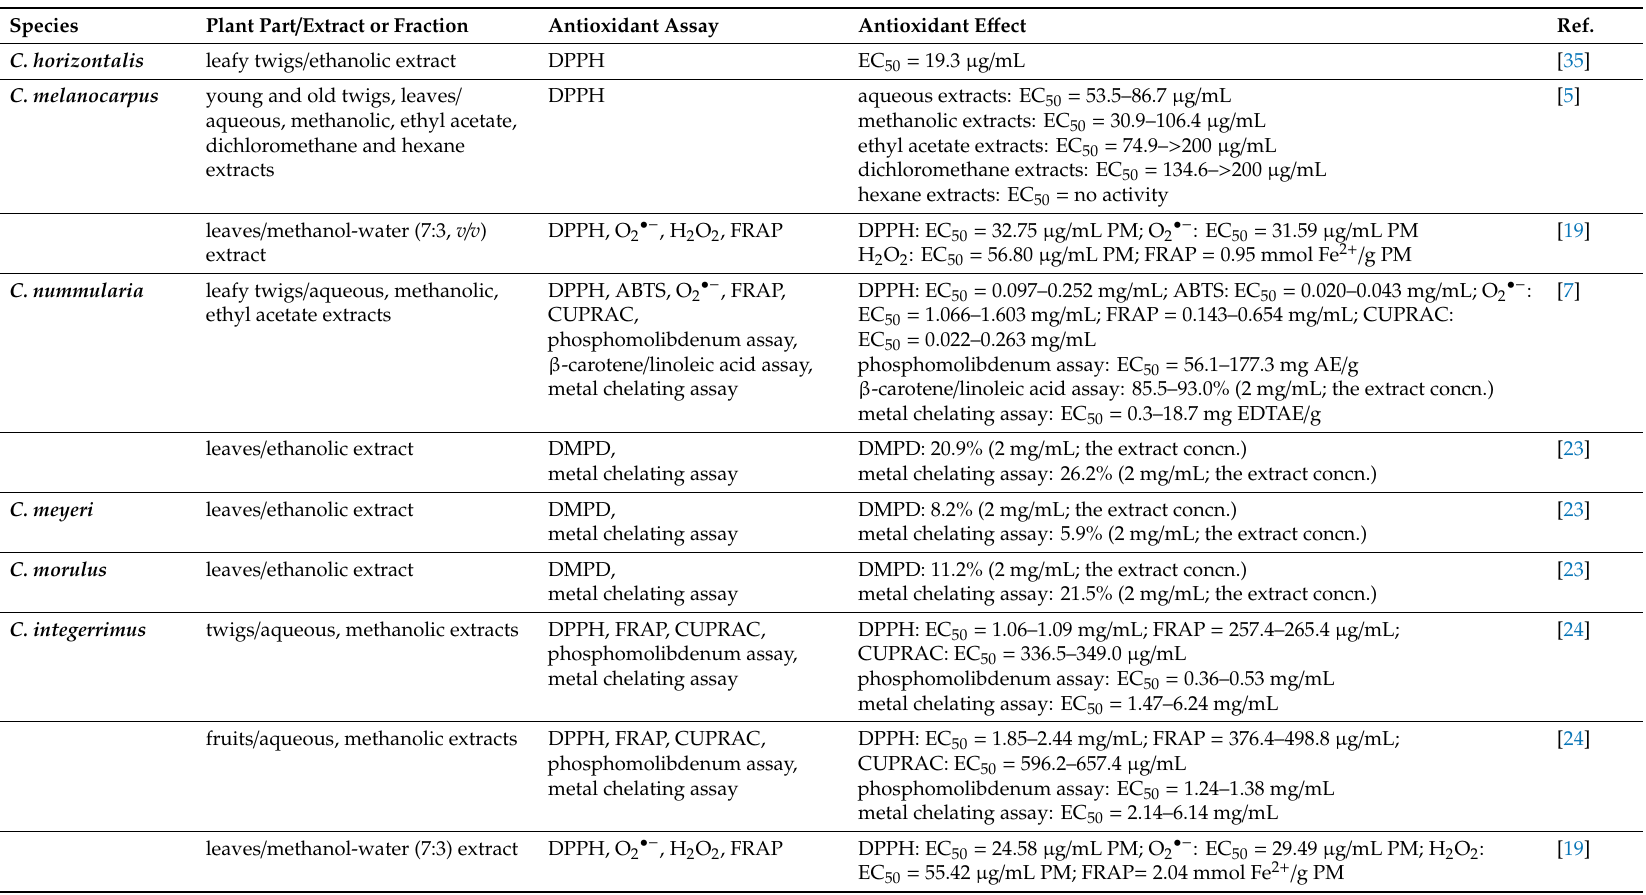
Table 2. Antioxidant activity reported for Cotoneaster